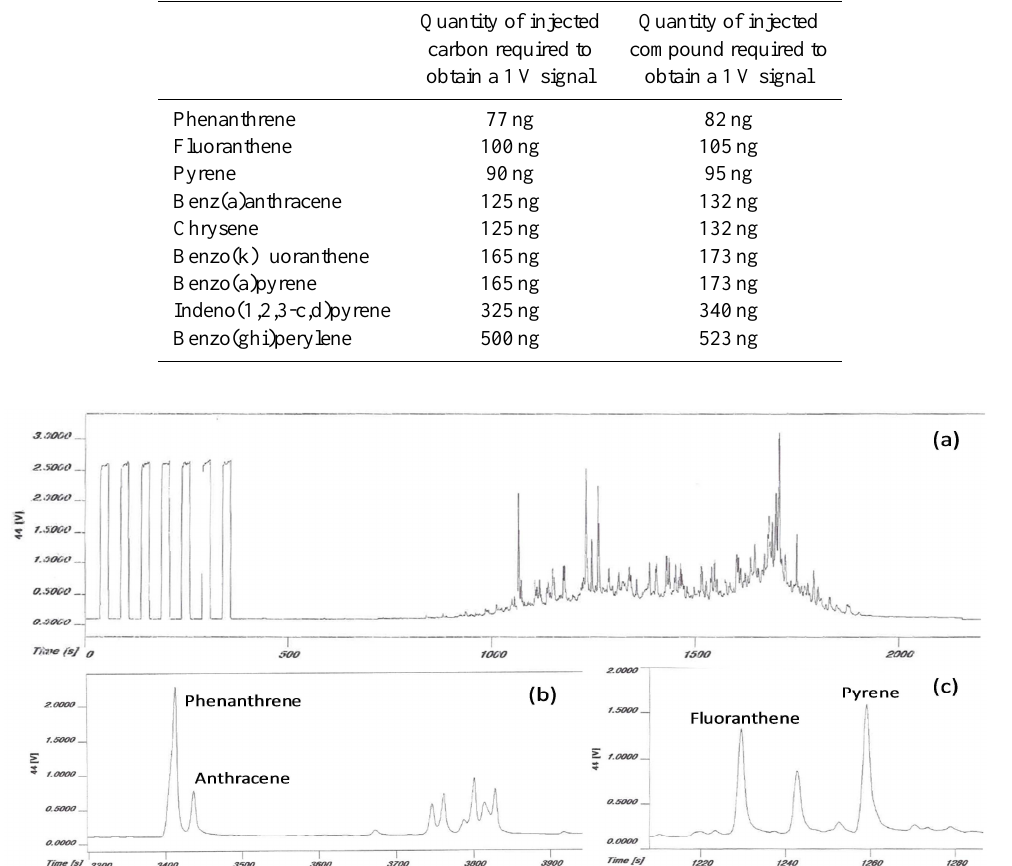
Table 3. Limits of quantification for the analysis of PAHs by GC/C/IRMS.